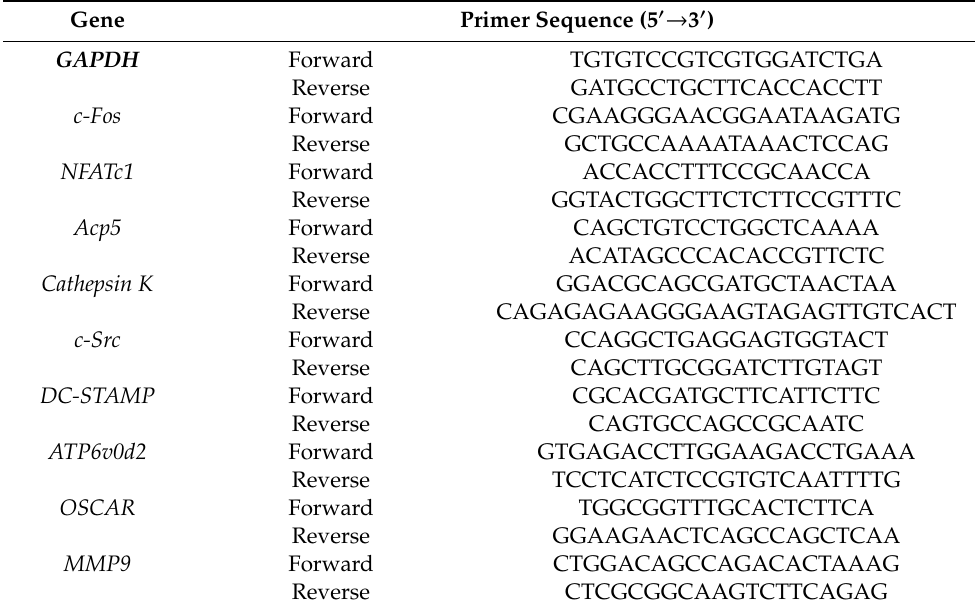
Table 1. Primers used in this study. Primer Sequence (5 (cid:48) → 3 (cid:48)